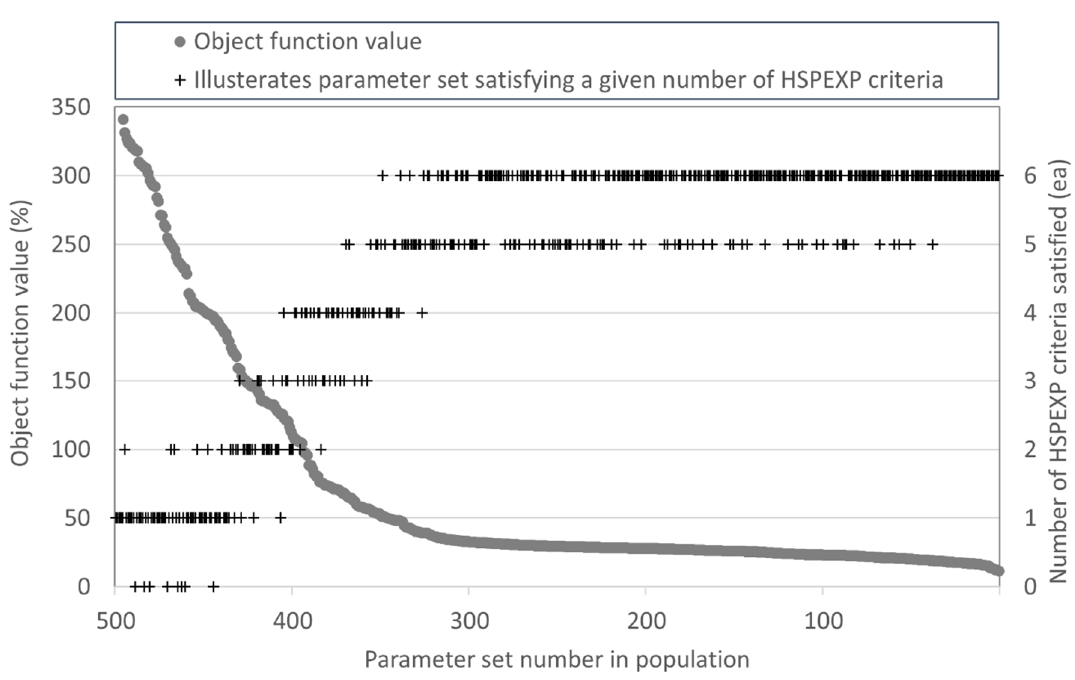
Figure 3. Objective function values and the number of HSPEXP criteria met by the final parameter set population using the SCE-UA algorithm of HSPF-SCE (Reed Creek